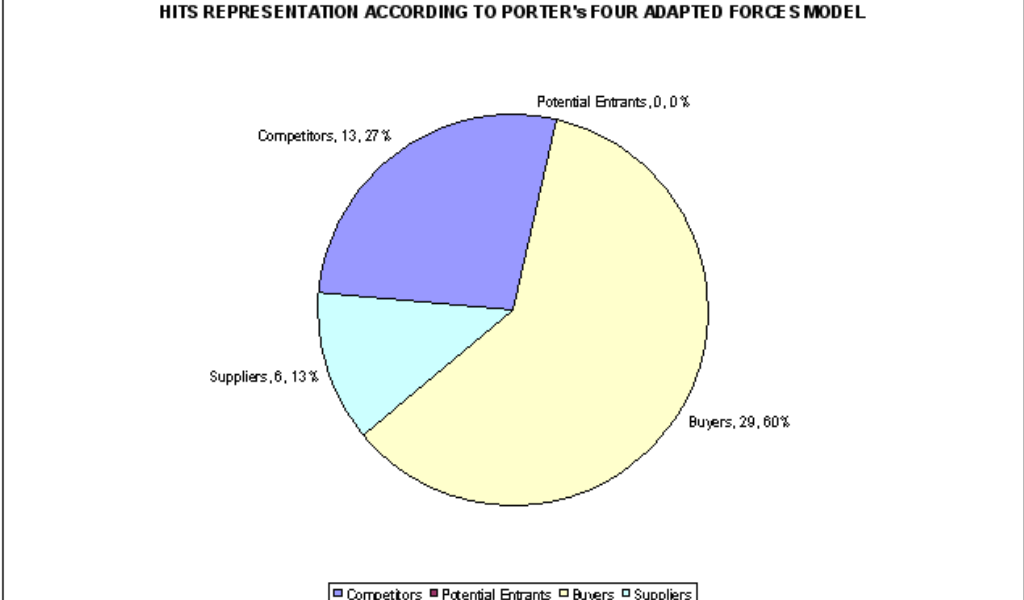
Figure 4 Enterprises providing a combination of